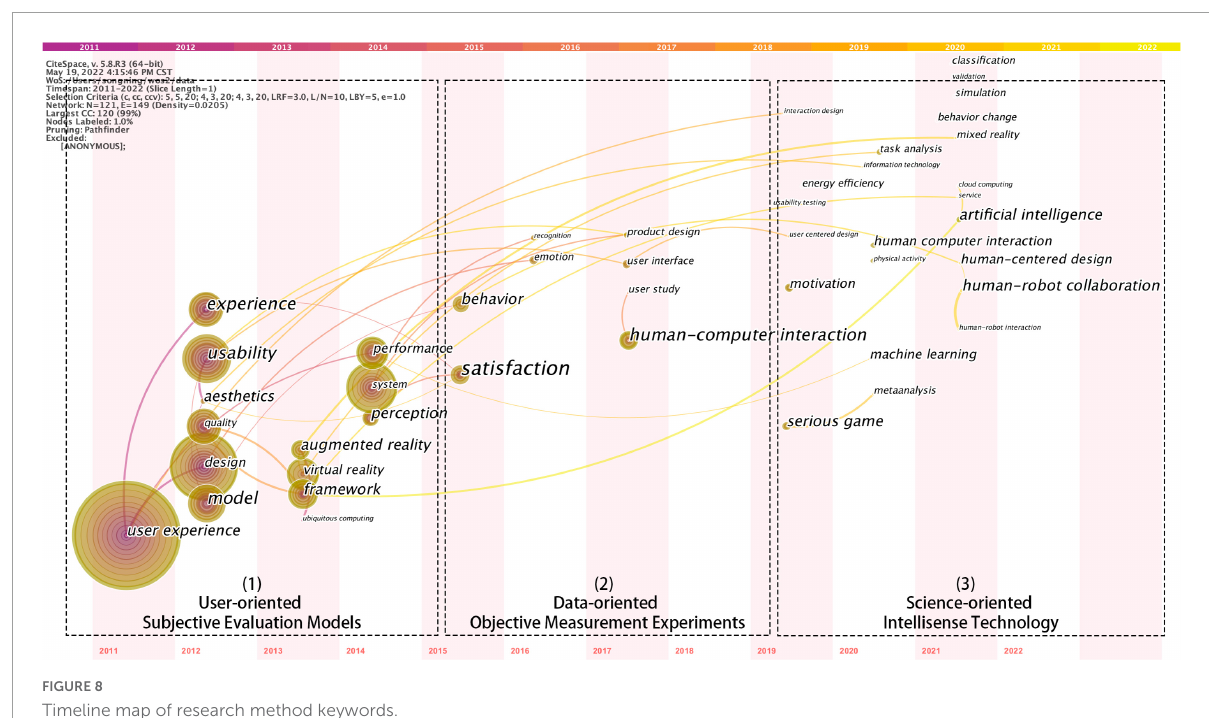
FIGURE8 Timeline map of research method